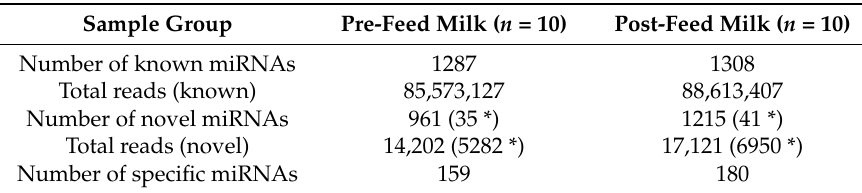
* High confidence novel miRNAs: novel miRNAs with > 20 total reads and identified in ě 4